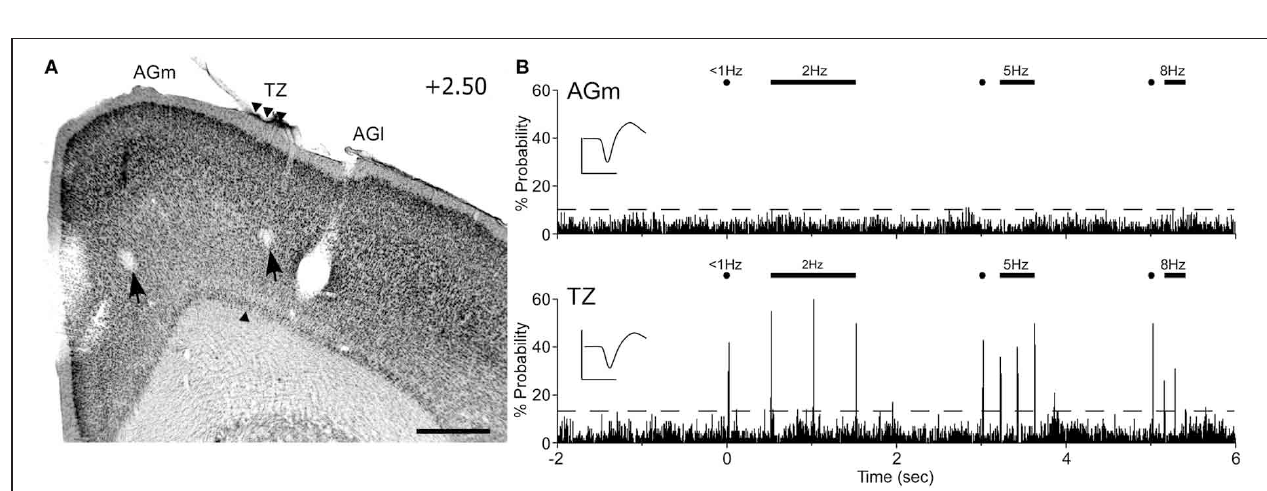
FIGURE 8 | Projections from SI and SII overlap in MI, but projections from SI and PPC terminate in adjoining MI areas. Left panels depict results from a rat in which SI and SII were injected with FR (red) and BDA (blue), respectively. Right panels depict results from a second rat in which SI and PPC were injected with BDA and FR, respectively. In both cases, the panels depict labeling patterns in tangential sections obtained from layers III